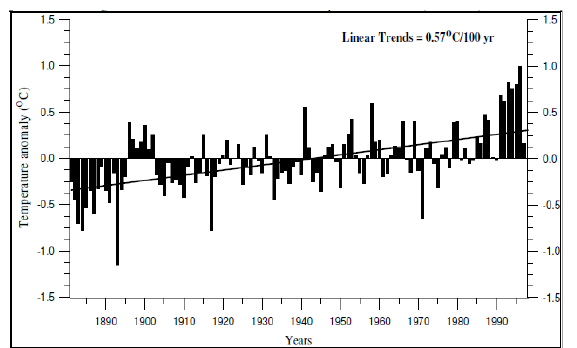
Figure 1. All India mean annual surface air temperature anomalies (1881 - 1997) [Source: Pant and Kumar (1997)]